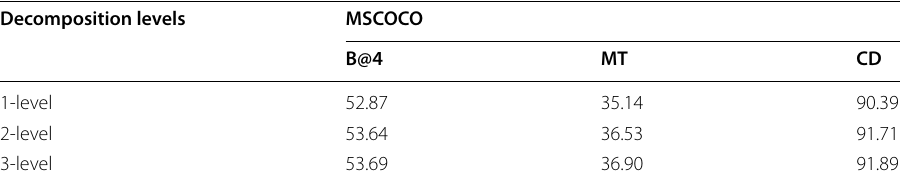
Table 3 Performance results of the proposed method for different number of decomposition levels on MSCOCO